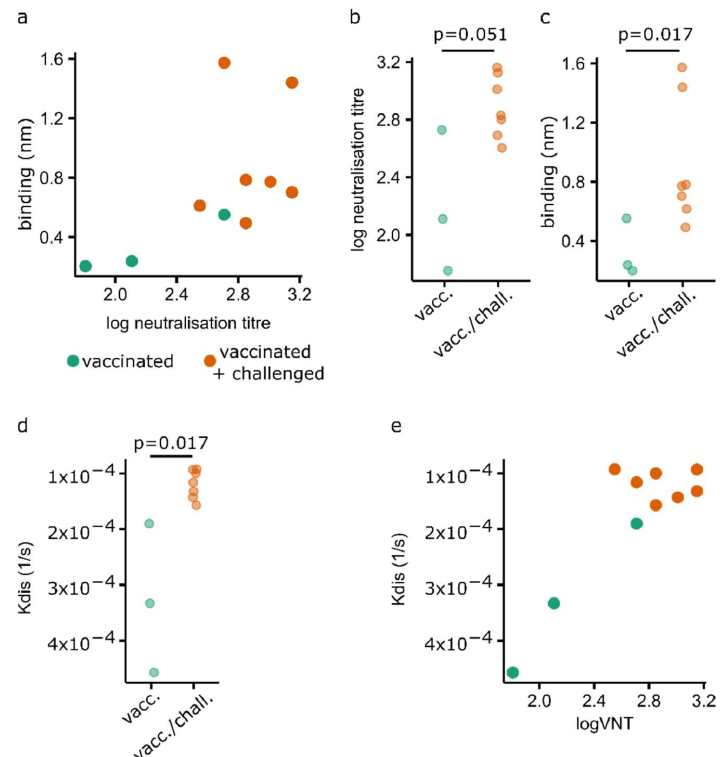
Figure 6. Binding and avidity characteristics of FMDV seropositive bovine serum. ( a ) The re- sponse values (nm) observed in BLI for different sera plotted against virus neutralisation titre (VNT). ( b ) Neutralisation titres of sera derived from vaccinated and vaccinated/challenged animals. ( c ) BLI binding values for sera derived from vaccinated and vaccinated/challenged animals. ( d ) Dissociation rates for sera derived from vaccinated and vaccinated/challenged animals. ( e ) Correlation between neutralisation titre and BLI dissociation